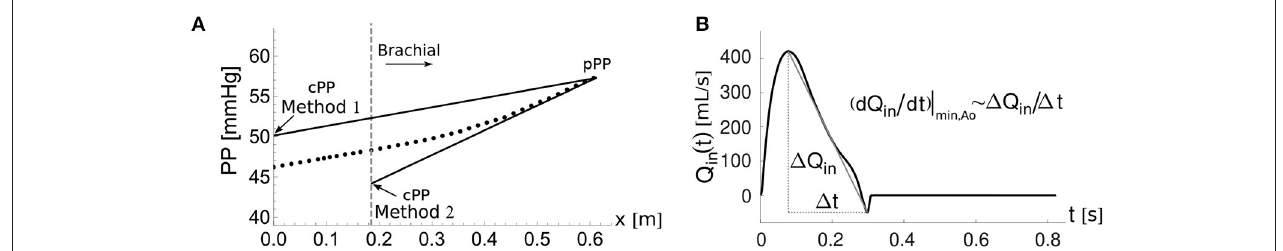
FIGURE 5 | The two cPP estimation methods. (A) Pulse pressure, PP(x), along the aortic-brachial arterial path with distance, x , from the aortic root. The start of the brachial artery is indicated by the dashed vertical line. PP values calculated along the path using the reduced model (dots). Methods 1 and 2 estimate cPP (solid lines) based on the approximate expression for PP(x) given by Equation (11), starting from the PP value at the outlet of the brachial artery, pPP. (B) Approximate calculation of the maximum temporal rate of decrease in late-systolic flow,